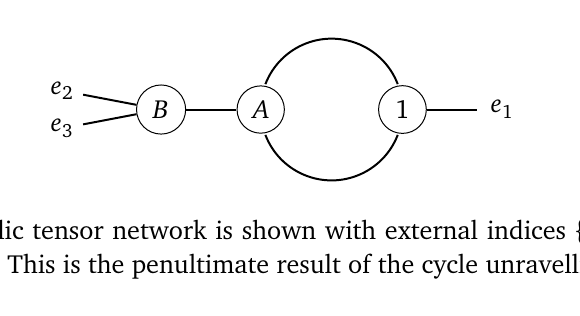
Figure 17: A cyclic tensor network is shown with external indices { e { i } for i ∈ { 1..3 } . This is the penultimate result of the cycle unravelling process. Figure 18: Shown is the final result of unravelling the cycle from Figure